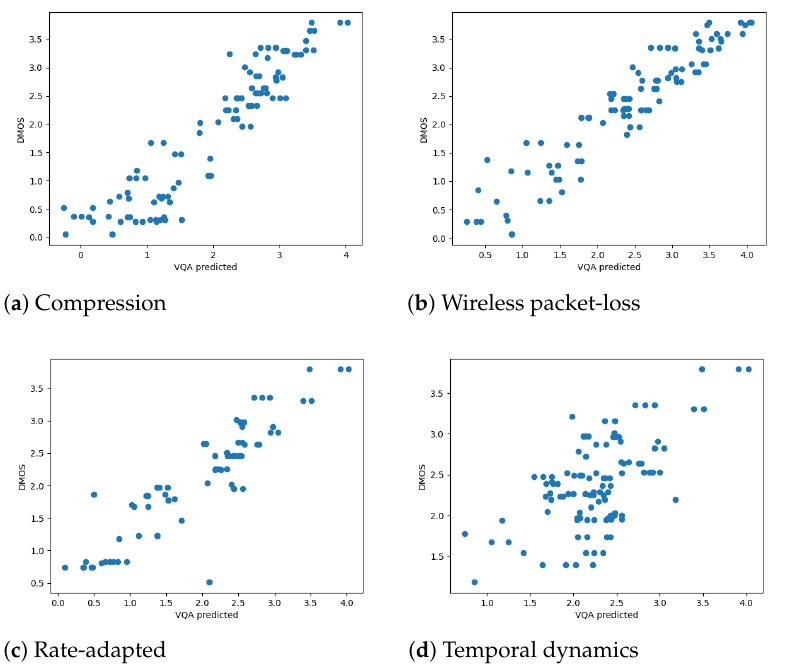
Figure 10. RAVA PSNR vs. DMOS for different distortion types.